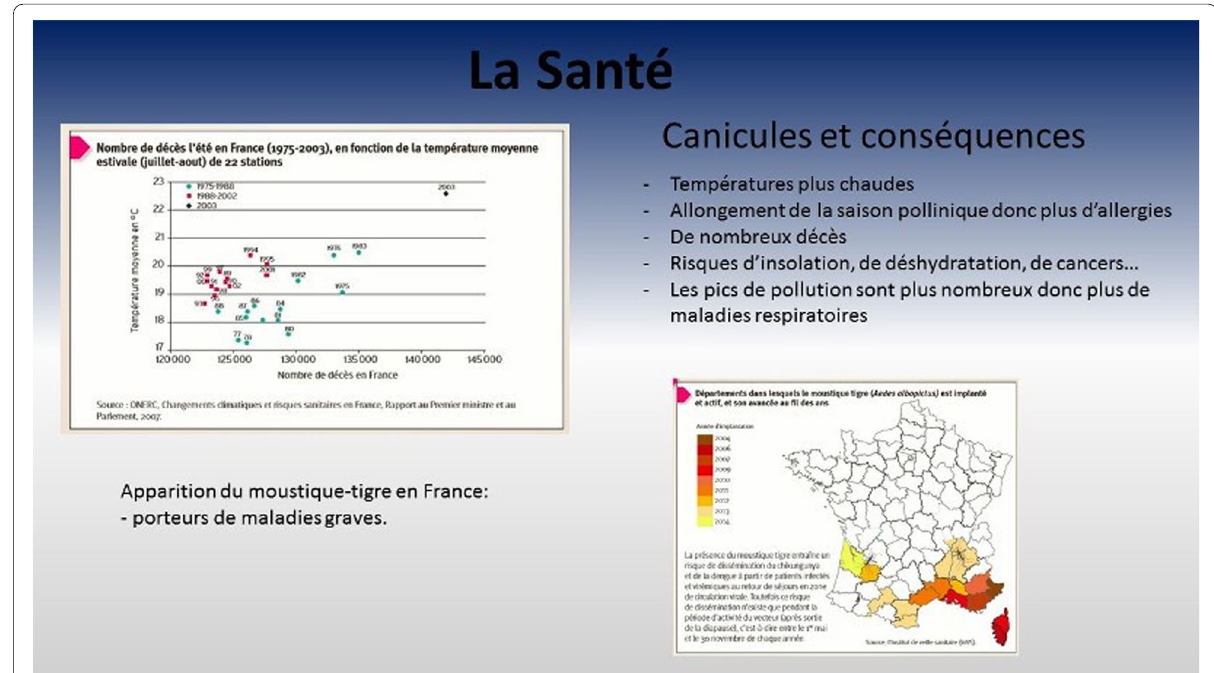
Fig. 6 Representative slide from student presentation on Health and climate change. Source: Kit pédagogique le changement climatique p 40. https:// resea uacti oncli mat. org/ publi catio ns/ kit- pedag ogique- chang ements- clima tiques/ [11]